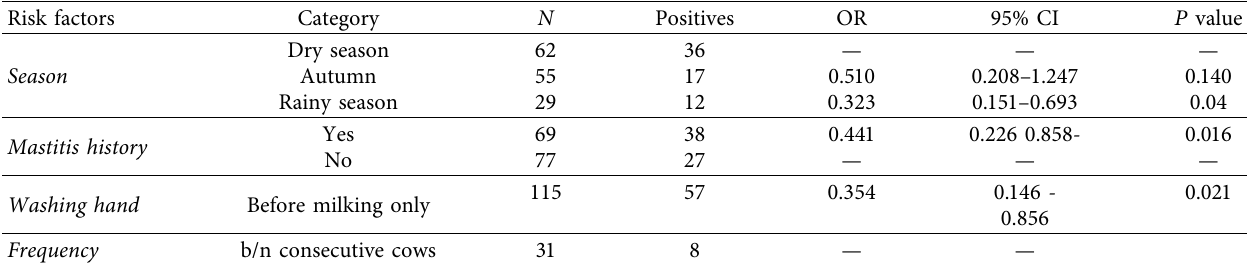
Table 2: Significant associative risk factors affecting the prevalence of bovine mastitis on 95% confidence